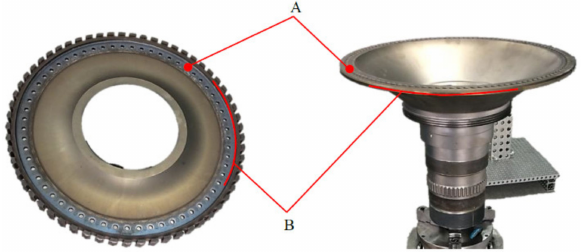
Figure 1. The actual rotor parts. A: Flange plane. B: Locating spigot